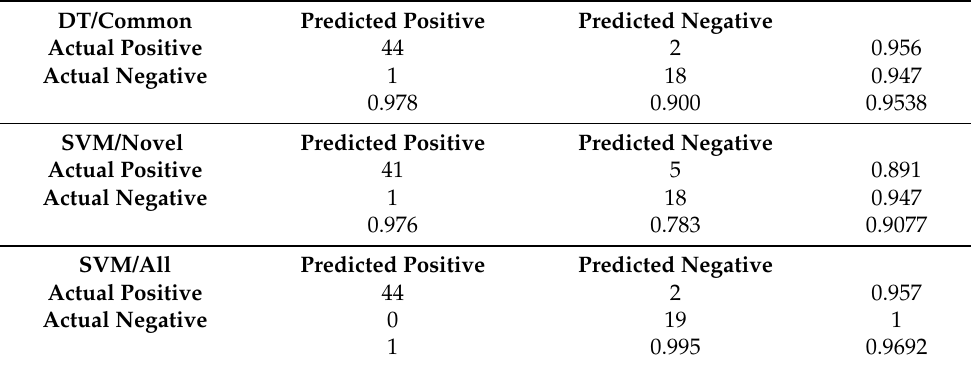
Table 6. Confusion matrices for the 2-class